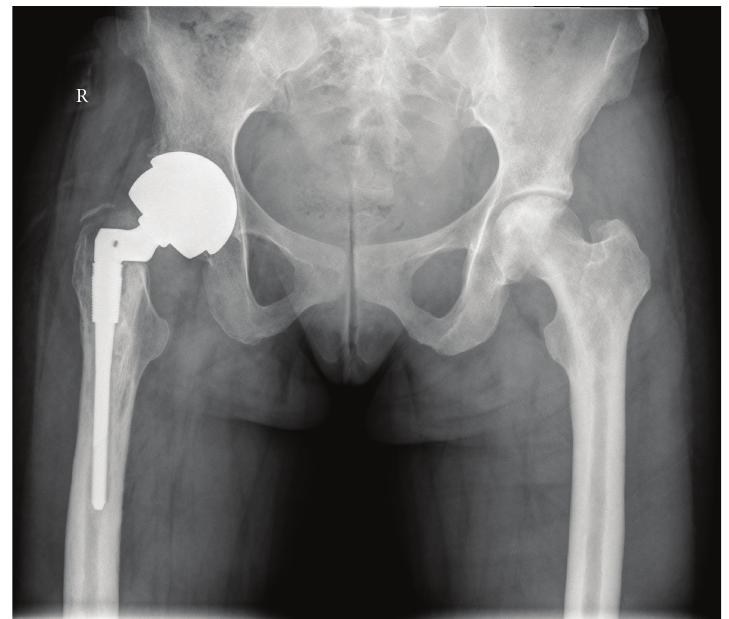
Figure 7: Plain radiograph of the pelvis showing sclerosis of the left femoral head consistent with avascular necrosis. Note total hip replacement due to premature secondary osteoarthritis secondary to avascular necrosis on the right.